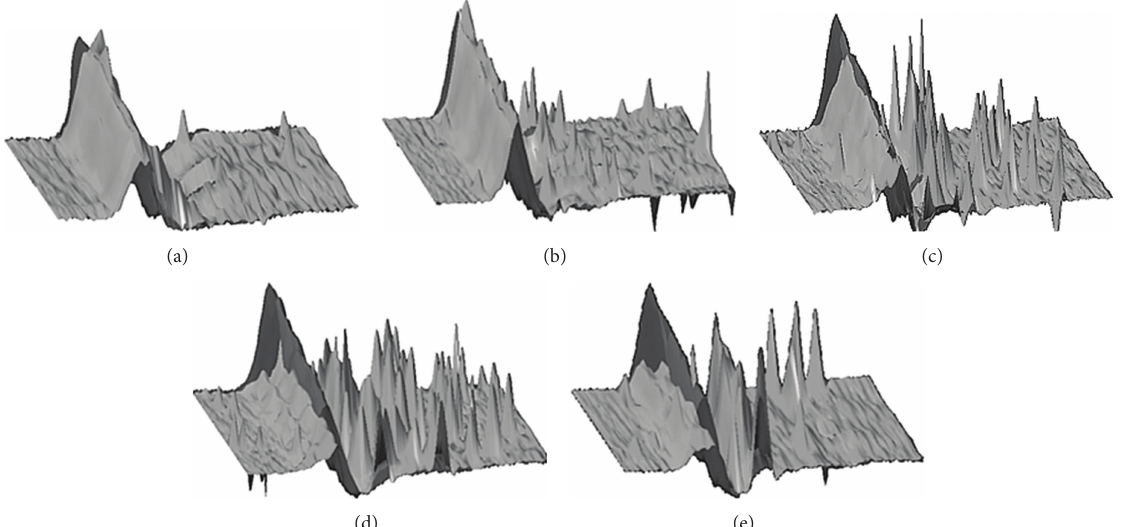
Figure 1: Monitoring of dynamic changes of hVOR with the vHIT in intratympanic gentamicin treatment. (a) Before therapy, (b)–(e) 1–4 weeks after therapy. Grey: hVOR: eye acceleration, black: head acceleration. Time-dependent reduction of hVOR gain and appearance of overt and covert refixation